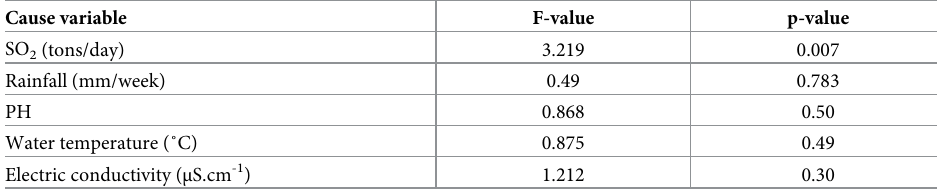
Table 5. Granger causality tests for the number of cholera cases and environmental variables (rainfall. water tem- perature. water electric conductivity and pH. volcanic sulphur dioxide emission) for 2007–2012 period. Katana Health Zone. DR Congo (n = 147 sampled dates).